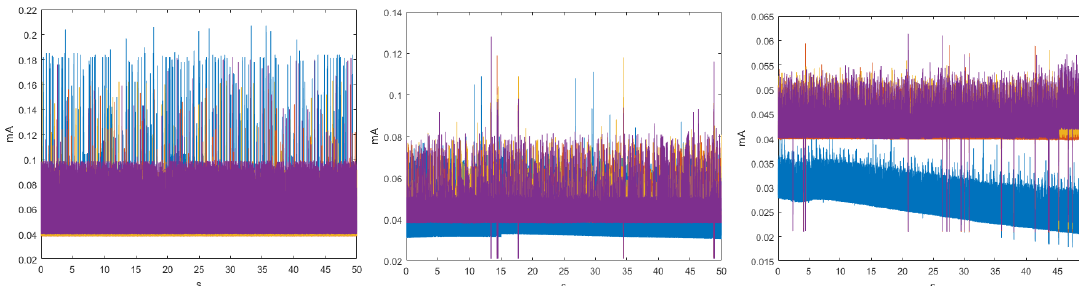
Figure 10. Time signals for ZigBee network at different NPLC. From left to right: 0.2, 2, and 10 NPLC.